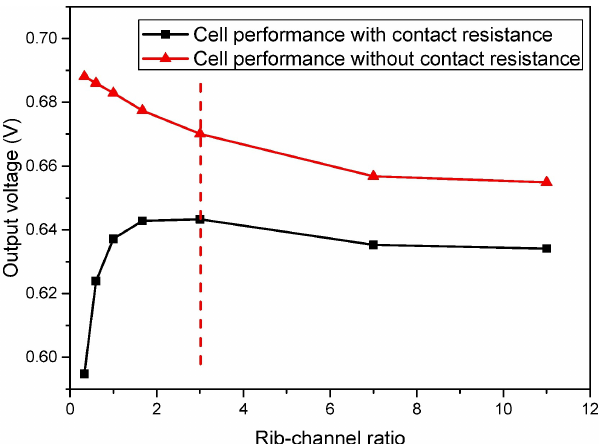
Figure 6. The performance of PEMFC with different channel-to-rib width ratio at a current density of 600 mA/cm 2